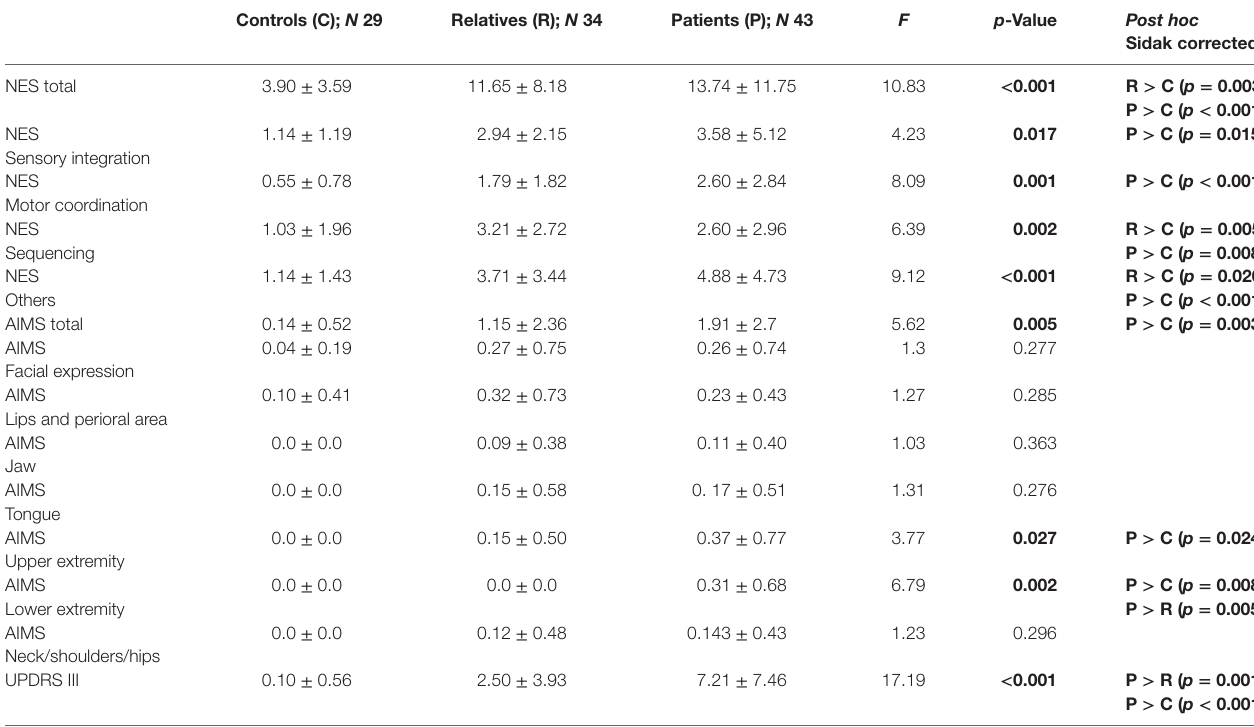
Table 3 | Group differences of neurological soft sign, dyskinesia, and Parkinsonism in patients, relatives, and controls. controls (c); N 29